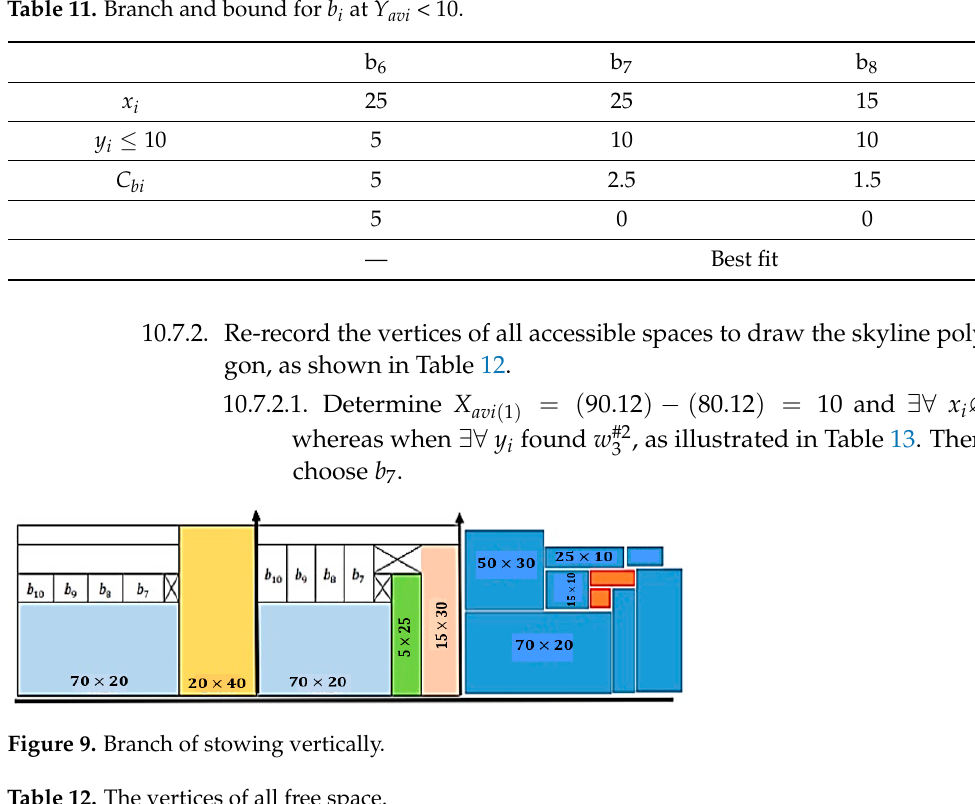
Table 11. Branch and bound for bi at Y avi < 10.